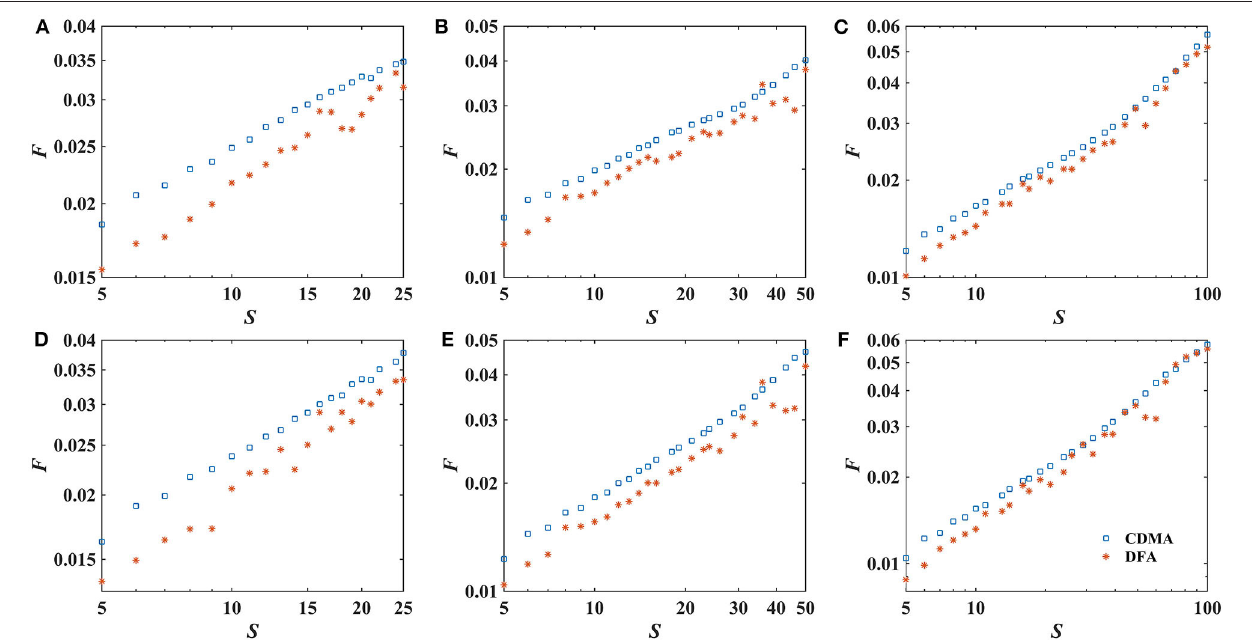
FIGURE 2 | Fluctuation function F with different rolling windows on 18 December 2015. (A–C) Depict the fluctuation function of WTI. (D–F) Illustrate the fluctuation function of Brent. From left to right, each column corresponds to 1, 2, and 4 years window.